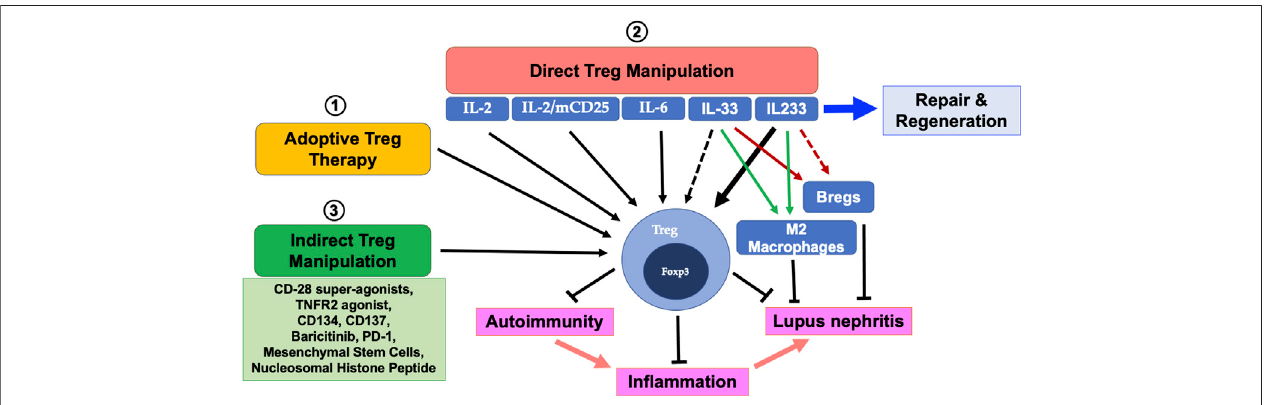
FIGURE 1 | Treg supplementation therapies for autoimmunity and lupus nephritis (LN): 1) Adoptive Treg transfer therapy has been successfully employed to attenuate in fl ammation and render protection in acute injury settings and recently, a similar approach was successfully employed in a SLE patient with bene fi cial outcomes. 2) CytokinesIL-2,IL-2/mCD25,IL-6andIL233havebeenshowntodirectlycause robustexpansionofTregswhichpreventsautoimmunityandLN.Whether IL-33, which is reported to exhibit its protective effects on LN through modulation of M2 macrophages and Bregs have a direct effect on Tregs is yet to be elucidated. Similarly, IL233 has been shown to expand Tregs and induce a M2 phenotype but its effects on Bregs are currently unknown. 3) Non-cytokine-based approaches using agonists, small molecules, mesenchymal stem cells and nucleosomal histone peptides have been shown to support Treg expansion to target